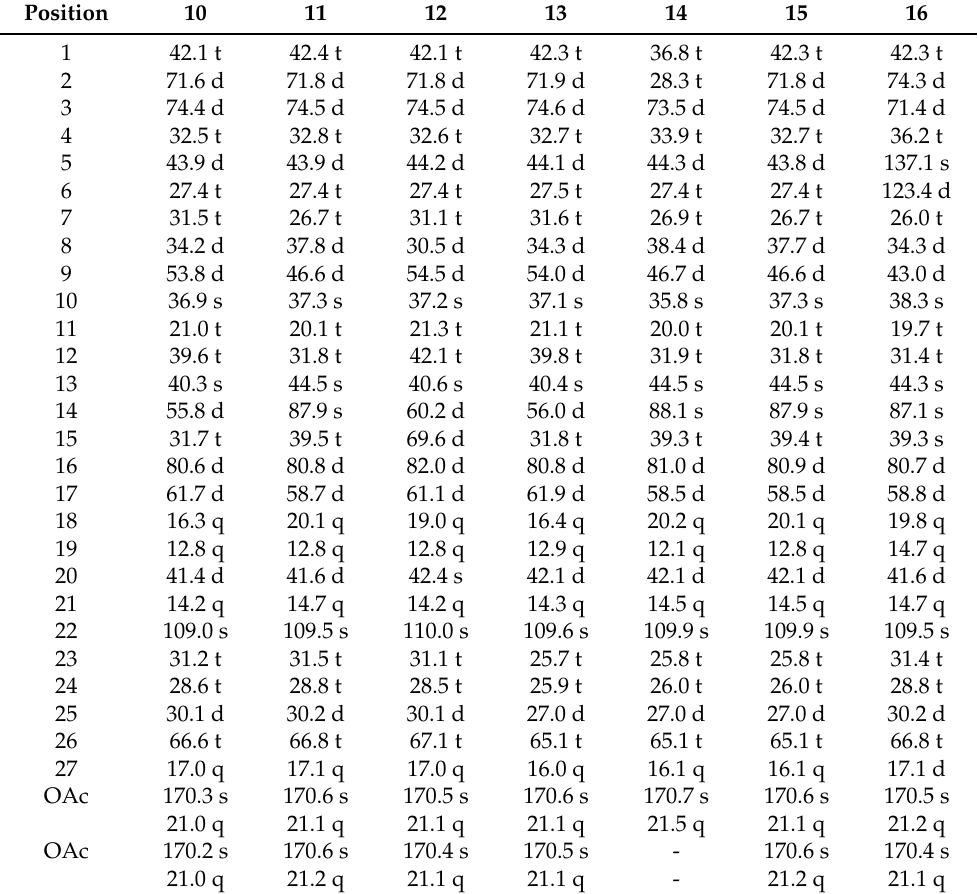
Table 5. 13 C-NMR Spectral Data of Compounds 10 – 16 (100 MHz, CDCl 3 , δ -values in